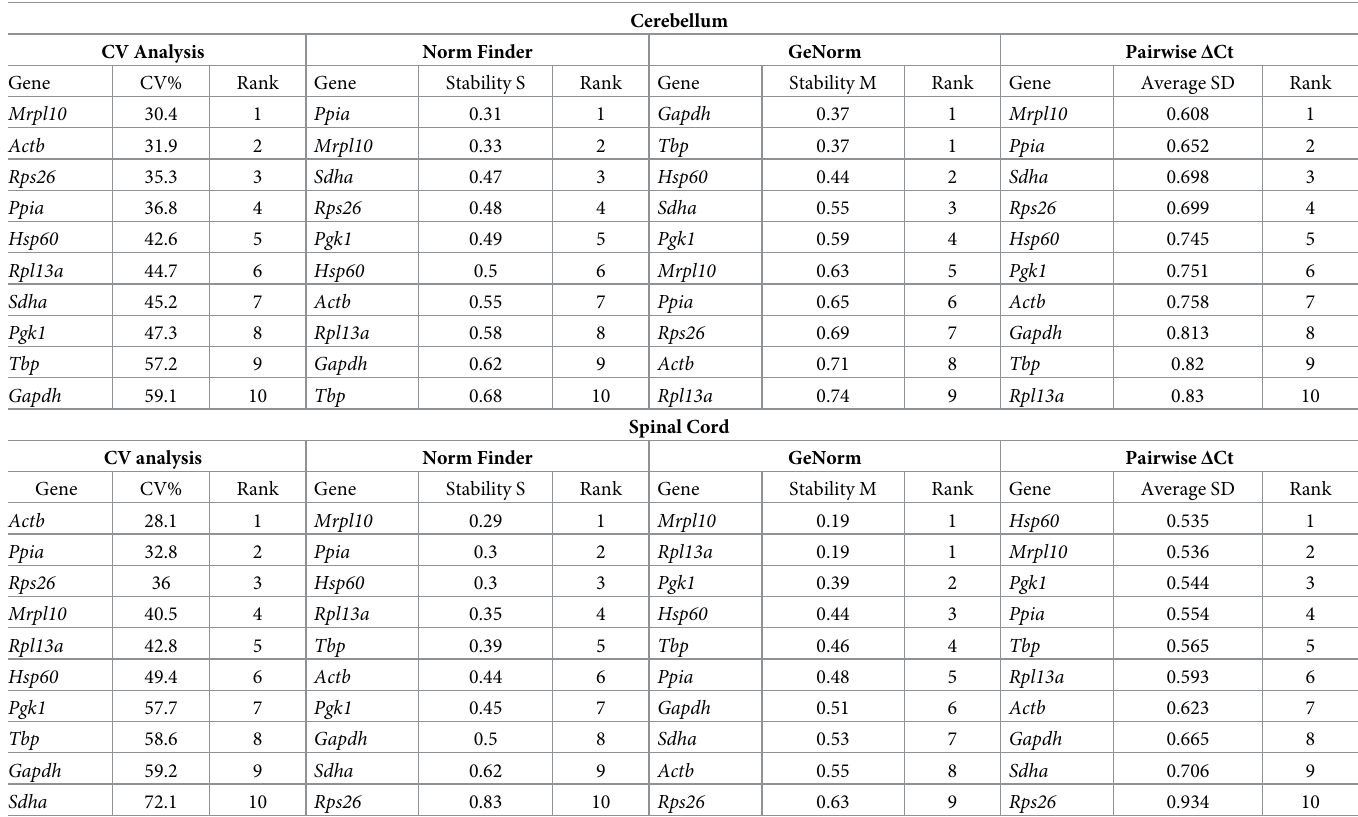
Table 1. Expression stability of candidate reference genes in cerebellum and spinal cord evaluated using Coefficient of Variation (CV) Analysis, NormFinder, GeN- orm and the Pairwise Δ Ct